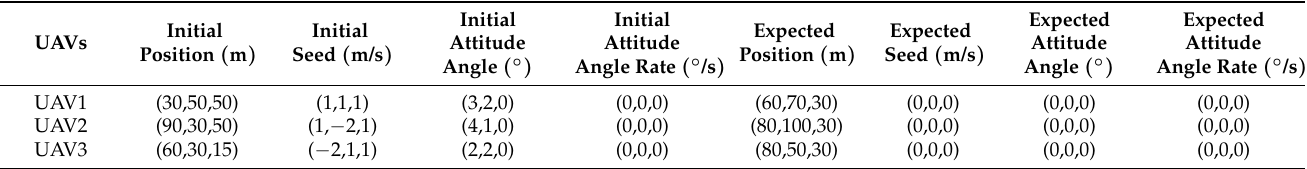
Table 1. Status variables of the